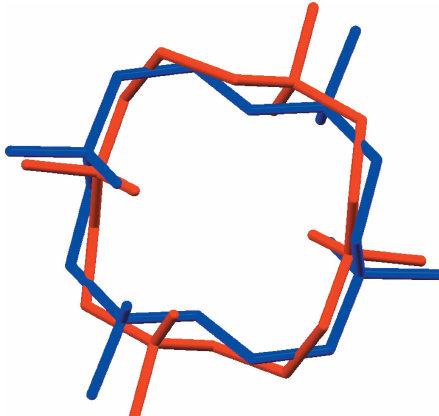
Figure 2 Overlay of the two macrocyclic cations in (I) (blue) and in [H 4 TMC](ClO 4 ) 2 Cl 2 (red).